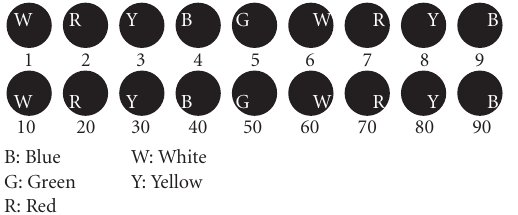
Figure 1: Marking system based on the position of the dots made with paint on the thorax of the bee. The black balls represent the thorax of the bee and the letters where the dots are made and the color of the